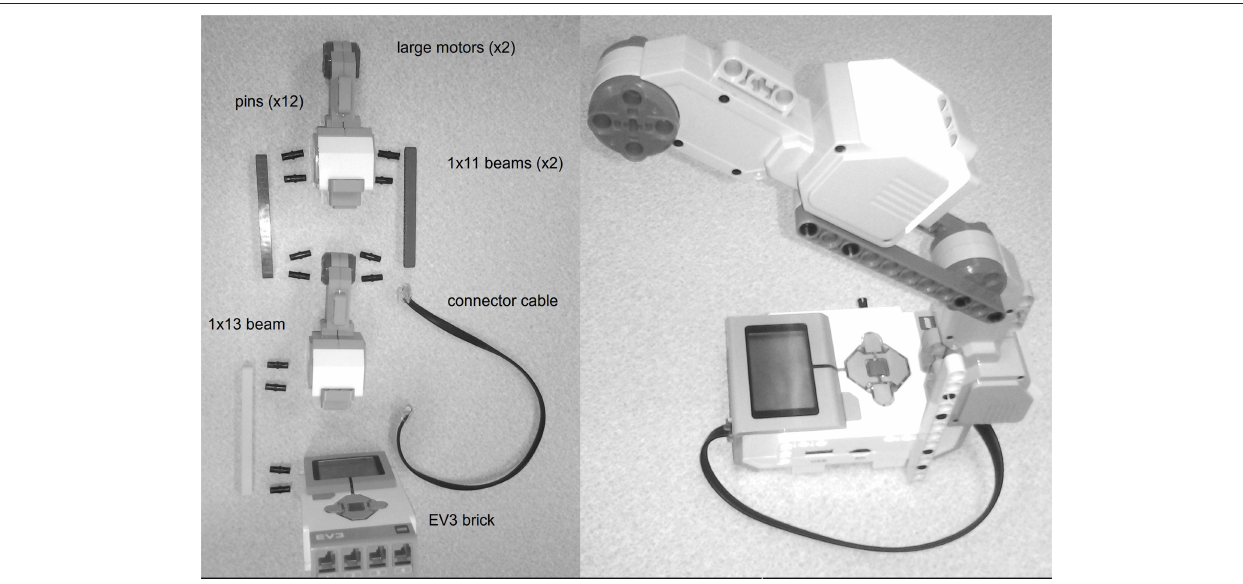
FIGURE 2 | A simple physical robot embodiment for calibrating the minimal simulation. All components come with the Lego Mindstorms EV3 kit, and are shown on the left (2 large motors; 2 1x11 beams; 1 1x13 beam; 12 pins; 1 EV3 brick; 1 connector cable). To rotate the central motor to the desired position q , enough force must be added to u to counteract the weight of the second unused motor.